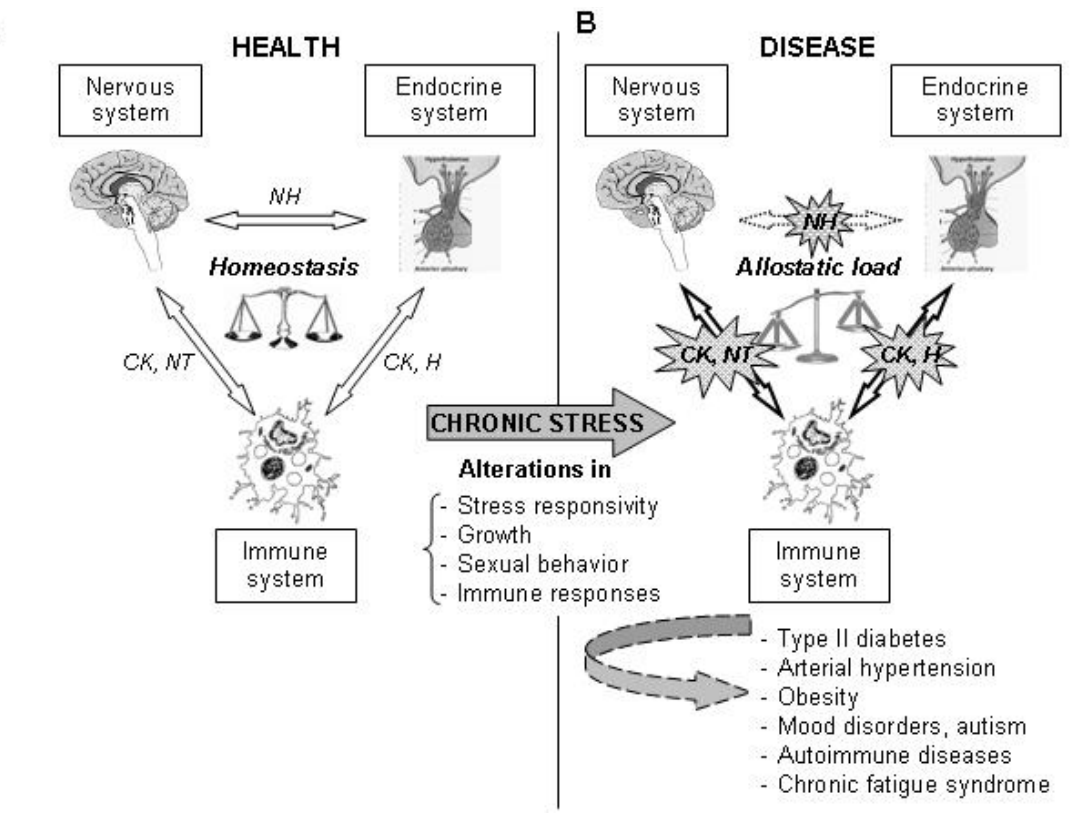
FIGURE 3 . Cross-talk between nervous, immune, and endocrine systems in health and in disease. (A) In physiological conditions, a permanent communication between nervous, immune, and endocrine systems underlies homeostasis in vertebrates. In particular, the HPA axis and the autonomic nervous system tightly interact with the immune system to generate adaptive responses to acute stress. The constant adjustments of these three fundamental systems to the many changes of the environment are responsible for a dynamic equilibrium, ensuring the survival of individuals in almost every environmental situation. Such reciprocal influences of the central nervous system, the immune system, and the endocrine system on each other are mainly mediated by neurotransmitters (NT), cytokines (CK), neurohormones (NH), and/or hormones (H). (B) When the living organism faces chronic stress situations, lasting perturbation of homeostasis might ultimately lead to diseases. Indeed, an inadequate communication between neuroendocrine and immune systems can contribute to the physiopathology of disorders associated with immune alterations, such as the chronic fatigue syndrome or autoimmune diseases. In such conditions of maladaptation, stress triggers lasting alterations in levels of NH, NT, CK, or H. The subsequent disequilibrium of the organism’s homeostatis leads to dysfunctions in stress responses, growth, sexual behavior, and/or immune responses, the first step in the programming of more severe disorders like type II diabetes, arterial hypertension, or obesity. In extreme situations, where the organism does not succeed in returning to homeostasis, such perturbations might ultimately cause the death of